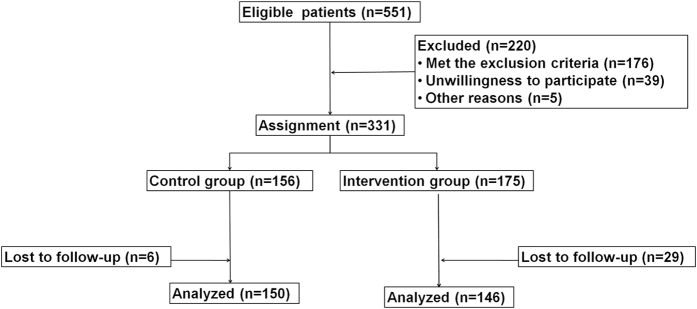
Patient flowchart.